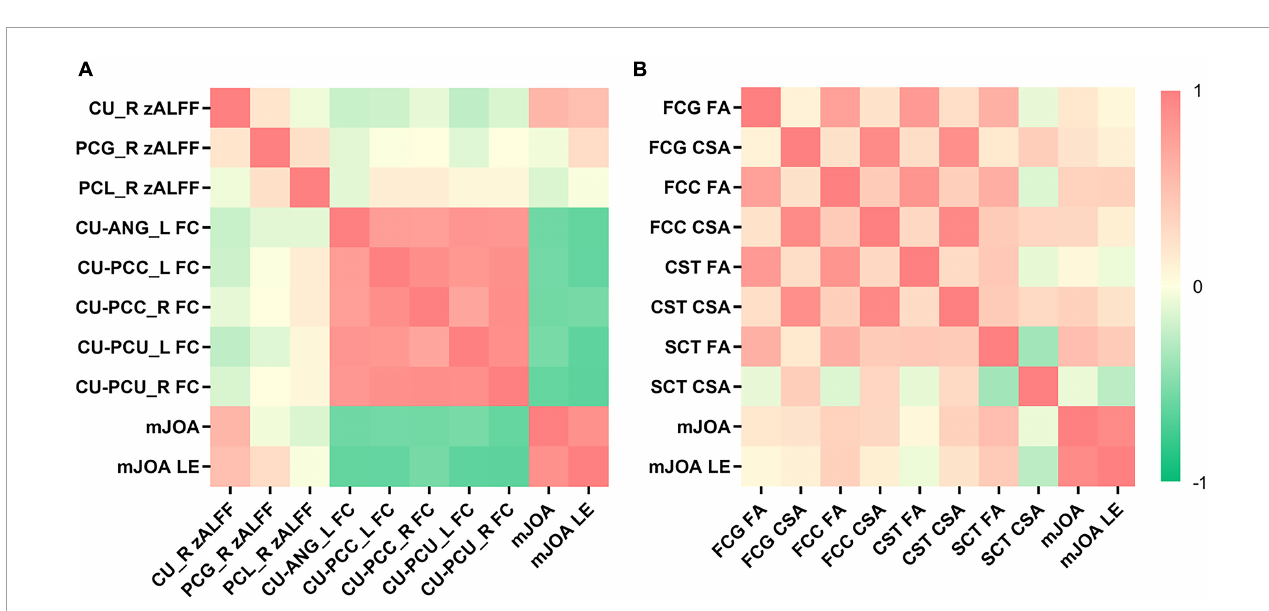
FIGURE4 The heatmap demonstrates the relationship between the cerebral functional magnetic resonance imaging (fMRI), spinal diffusion tensor imaging (DTI) parameters and clinical scale scores. (A) Patients’ modified Japanese Orthopedic Association (mJOA) and mJOA lower extremity scores were positively correlated with caudate z-score transformation amplitude of low-frequency fluctuations (zALFF). Patients’ mJOA and mJOA lower extremity scores were negatively correlated with the FC between the caudate nucleus and left angular gyrus, bilateral precuneus, and bilateral PCC. (B) Patients’ mJOA were positively correlated with FA of the SCT at C2 level. CU, caudate nucleus; ANG, angular gyrus; PCU, precuneus; PCC, posterior cingulate cortex; FCG, fasciculus gracilis; FCC, fasciculus cuneatus, CST, lateral corticospinal tract; SCT, spinocerebellar tract; LE, lower